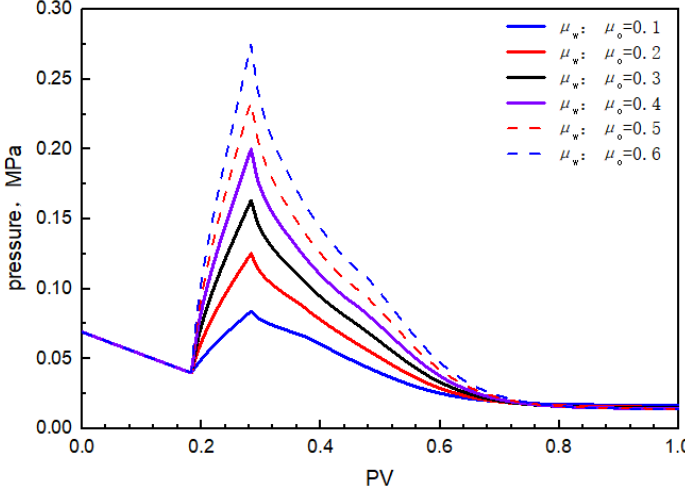
Figure 20. The injection pressure under different viscosity conditions.